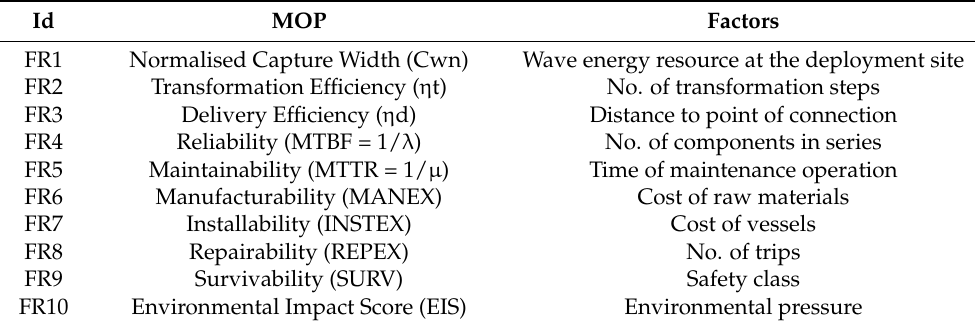
Table 14. Degree of difficulty factors for